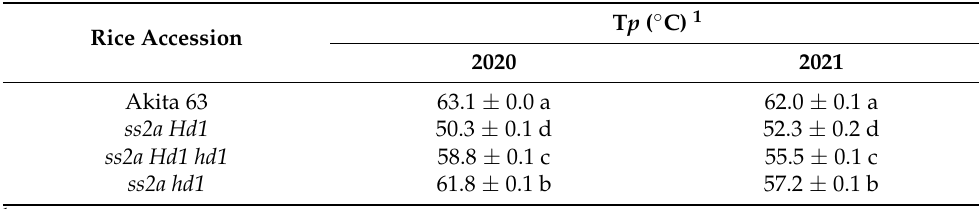
Table 3. Peak gelatinization temperature (T p ) of starch purified from rice grains harvested in 2020 and 2021, as analyzed via differential scanning